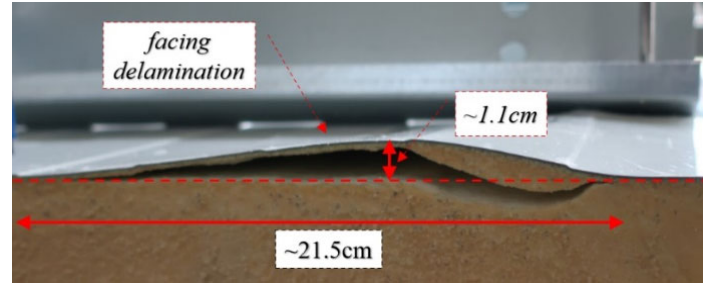
Figure 12. Tightened blind rivet: ( a ) equilibrium load ‐ displacement paths, ( b ) connection behaviour in stage I.